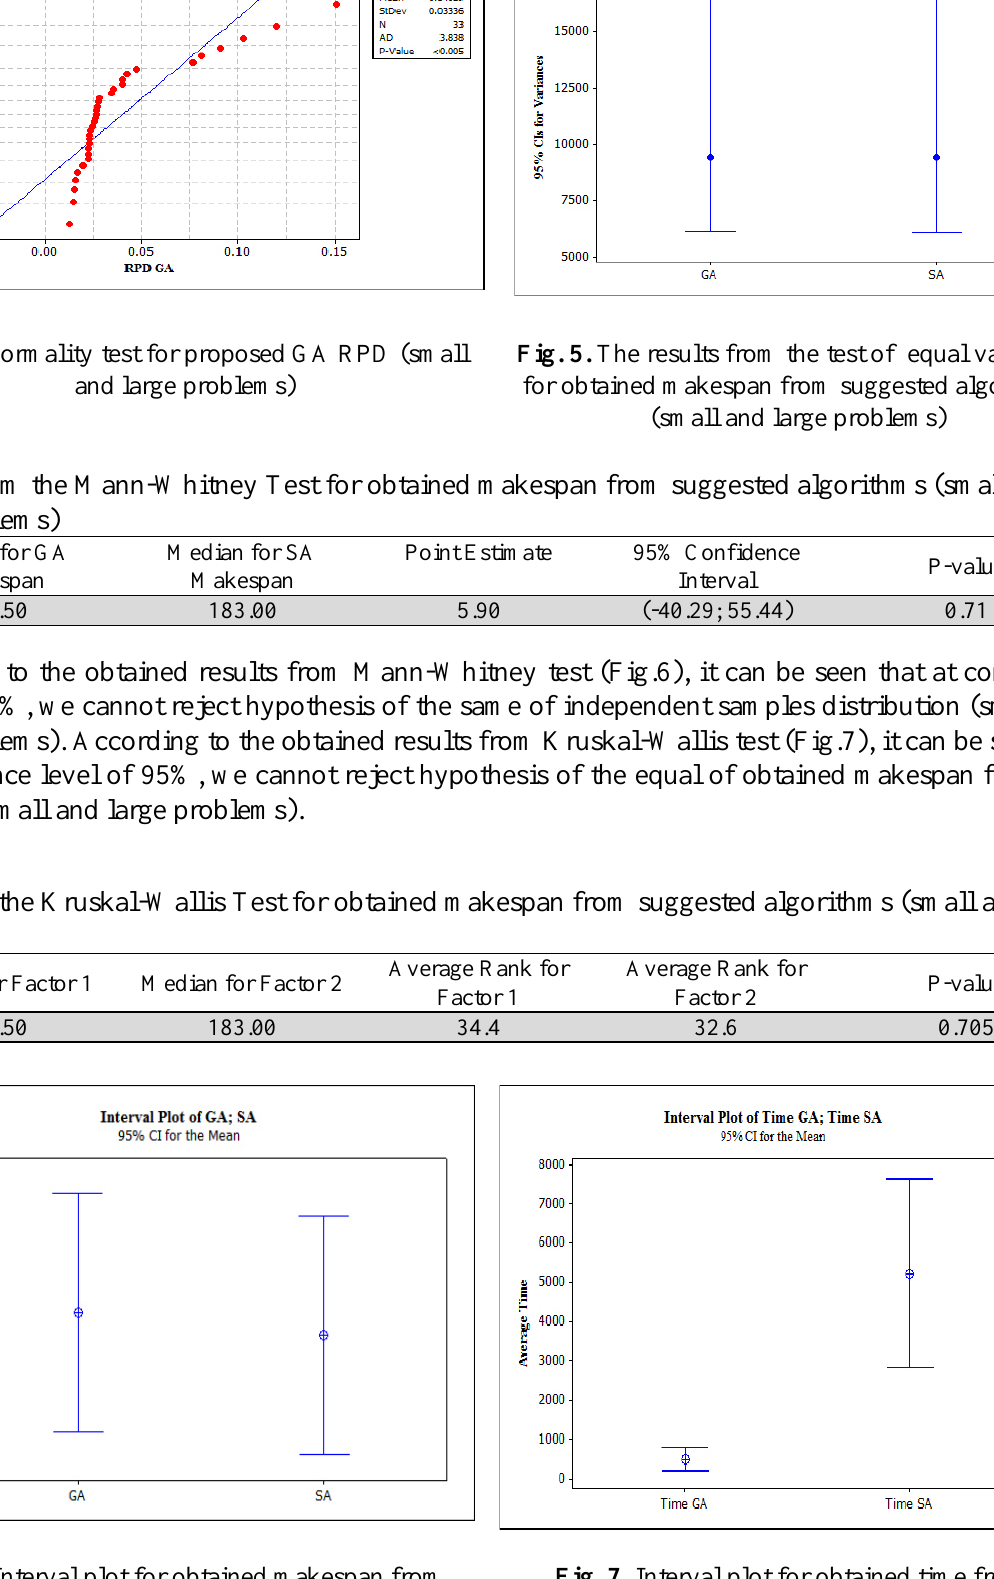
Fig. 7. Interval plot for obtained time from suggested algorithms (small and large